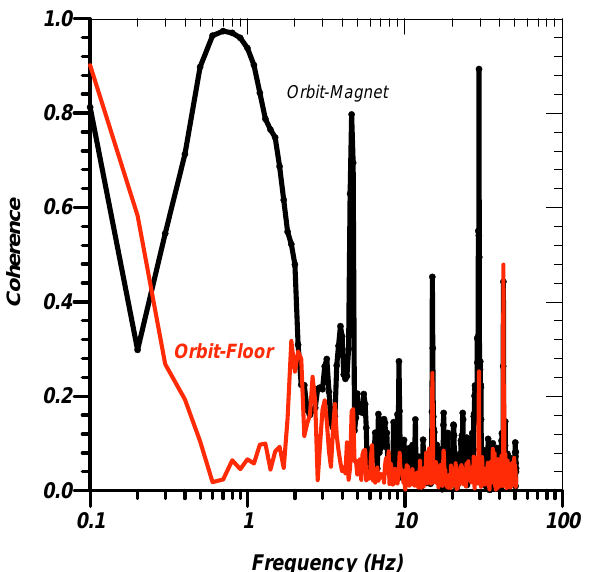
FIG. 10. Maximum ground velocity in the Aurora mine.